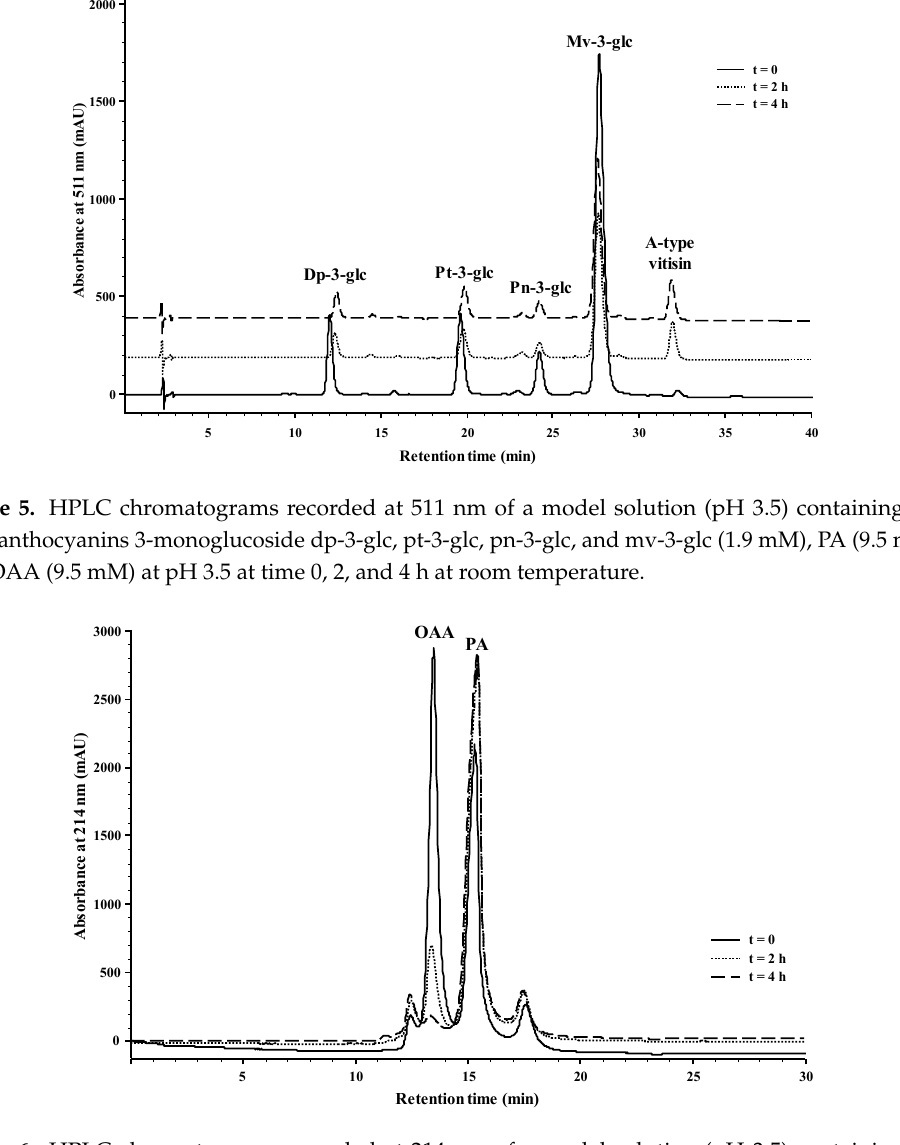
Figure 6. HPLC chromatograms recorded at 214 nm of a model solution (pH 3.5) containing the wine anthocyanins 3-monoglucoside dp-3-glc, pt-3-glc, pn-3-glc, and mv-3-glc (1.9 mM), PA (9.5 mM), and OAA (9.5 mM) at pH 3.5 at time 0, 2, and 4 h at room temperature.